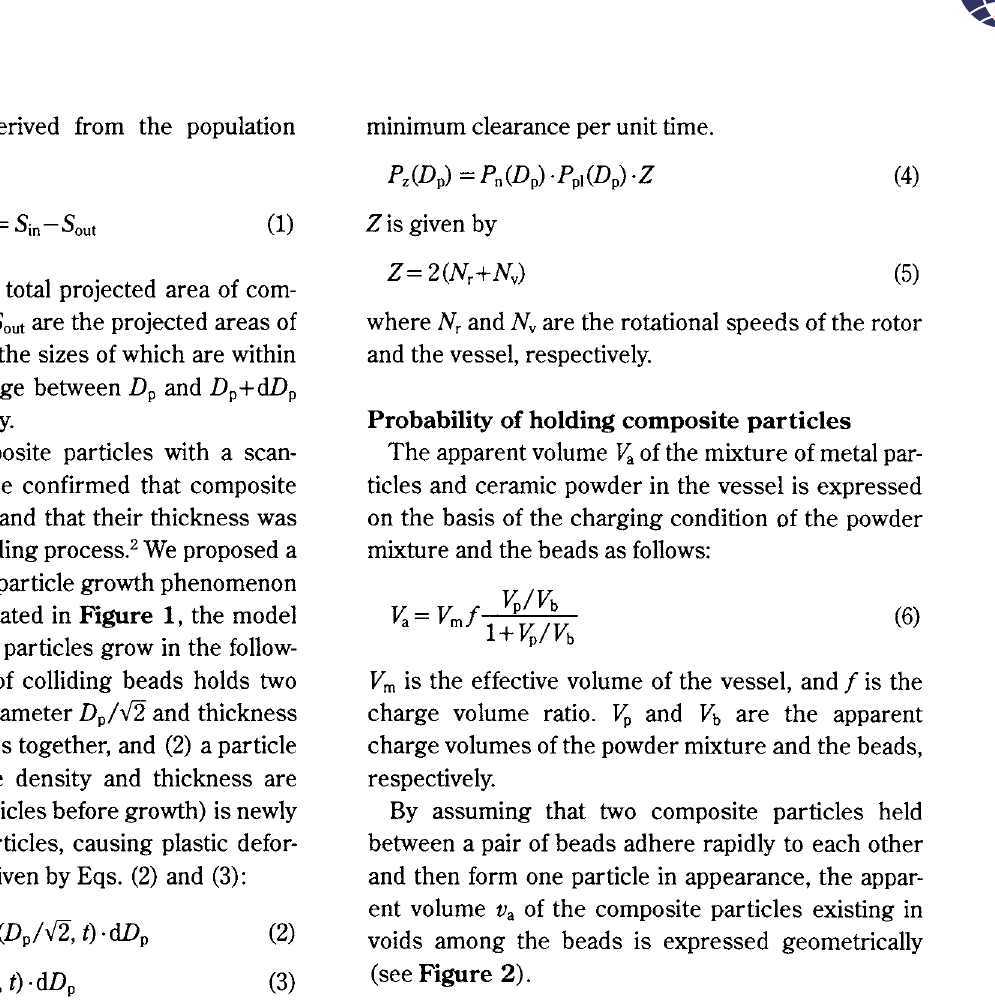
Fig. 1 Compounding model for disk-shaped particles